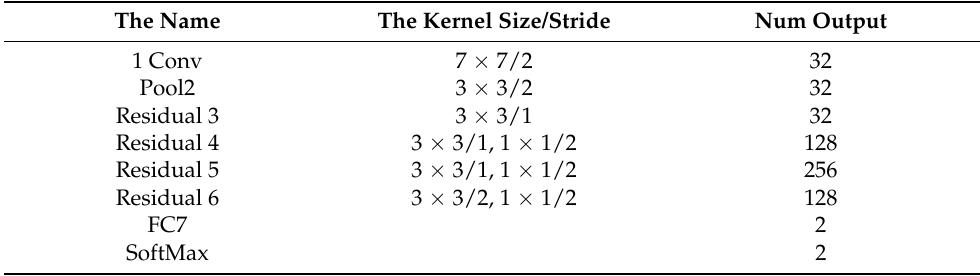
Table 1. Network structure of the filter.